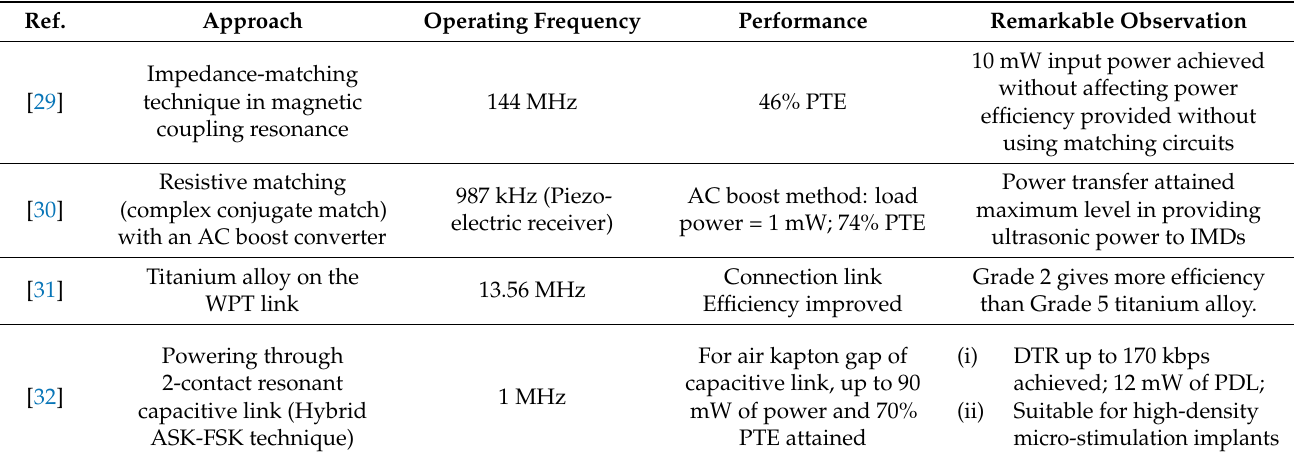
Table 2. WPT systems focusing on an impedance-matching role.